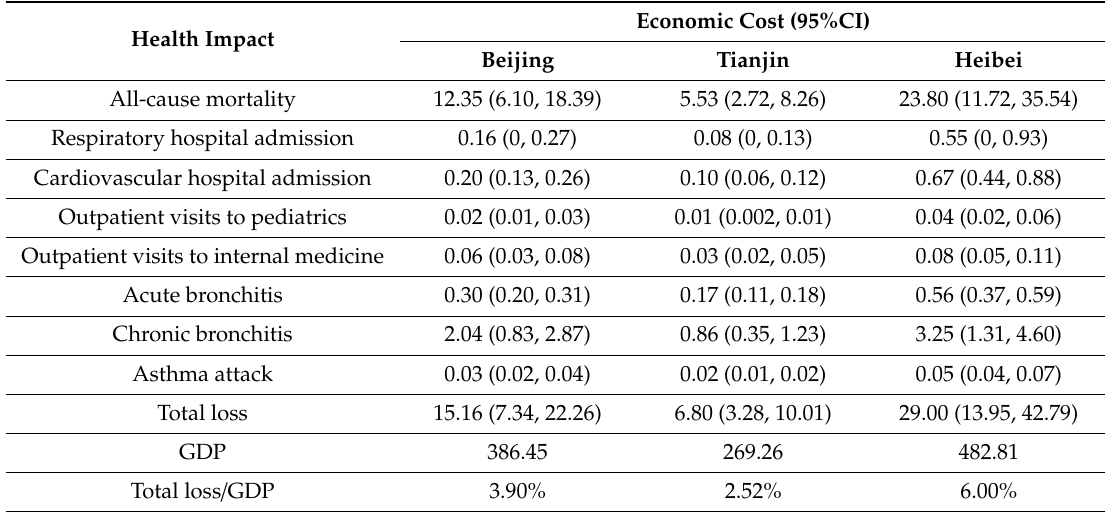
Table 5. Average total economic cost (billion USD) as a proportion of the BTH’s average GDP.